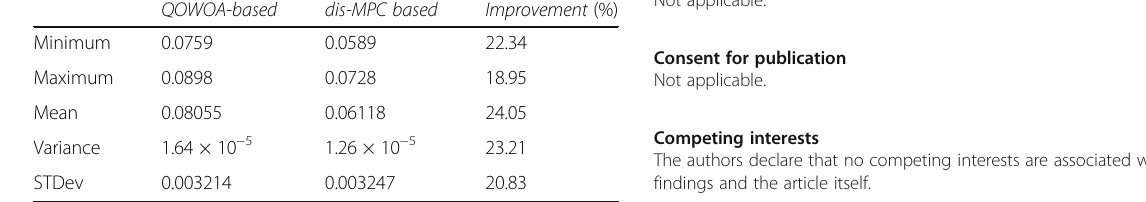
Table 2 Performance measures for 20 runs of ITAE values